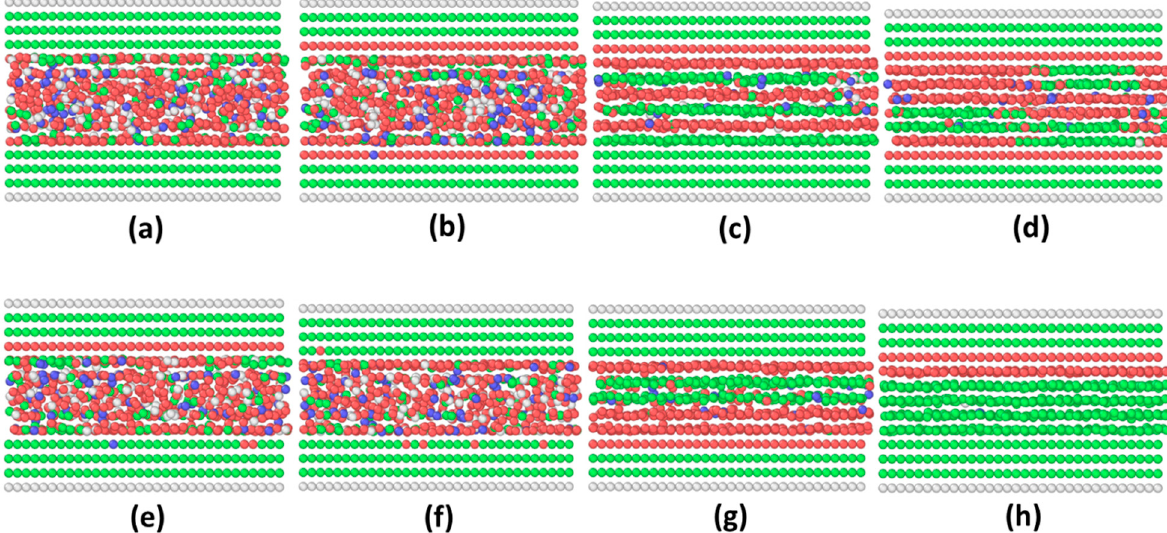
Figure 6. Equilibrium phases of argon molecules confined between two commensurate contacts predicted in GCMC/MD simulations with chemical potential μ = − 2.21 kcal/mol for varying thicknesses: ( a ) 6.5 Layer + 1.0Å, ( b ) 6.5 Layer + 0.5Å, ( c ) 6.5 Layer, ( d ) 6 Layer, ( e ) 5.5 Layer + 1.0Å, ( f ) 5.5 Layer + 0.5Å, ( g ) 5.5 Layer, and ( h ) 5 Layer. They are consistent with those observed in LVMD simulations as shown in Figure A1.